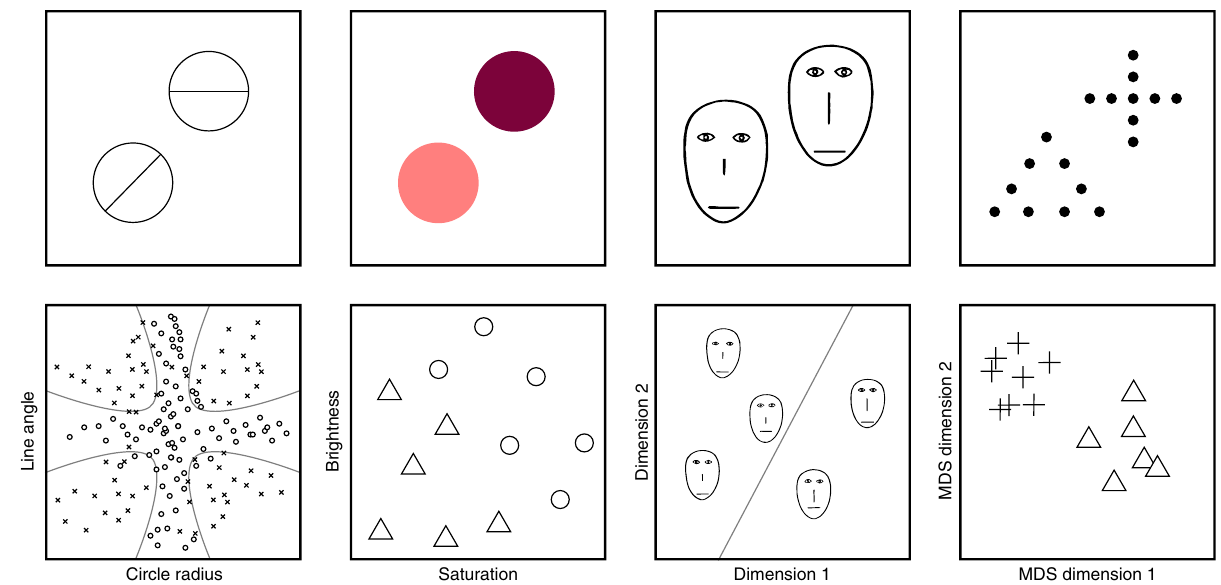
Fig. 1 Stimuli from previous seminal studies of categorization. The top row shows representative stimuli, the bottom shows the types of stimulus representations used as input to categorization models. Stimuli and category distributions reproduced to roughly replicate those used in the following studies: left 17 , center left 28 , center right 12 , right 30 (although for the center right panel, stimulus distributions were represented — and linearly separable — in four dimensions 12